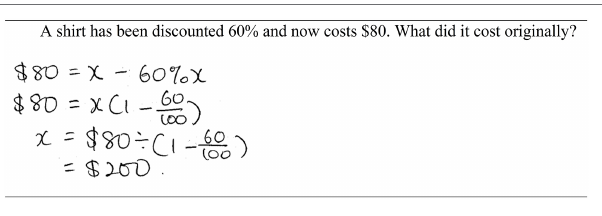
FIGURE 6 | A solution of a challenging percentage decreased problem that shows step skipping